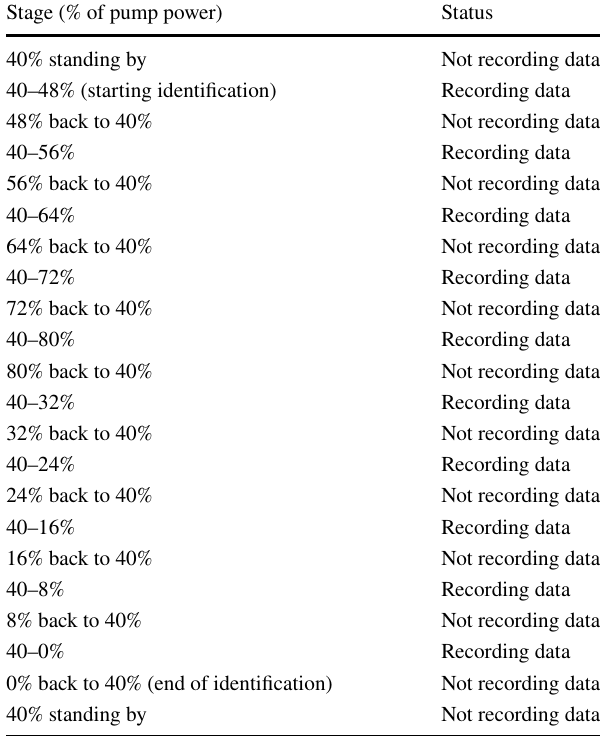
Table 1 Automated procedure developed based on SK